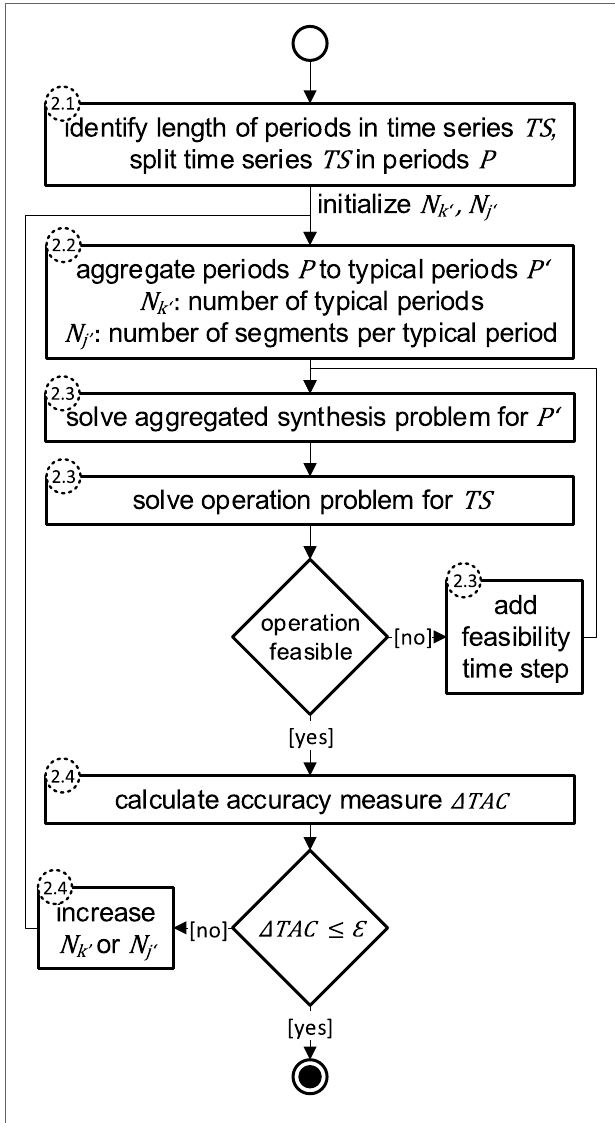
FIGURE 1 | Method for time-series aggregation to typical periods P ′ while bounding the error of aggregation ∆ TAC in the domain of the objective function (total annualized cost TAC ) below a threshold value " . Details on the proposed steps can be found in the subsections (dotted